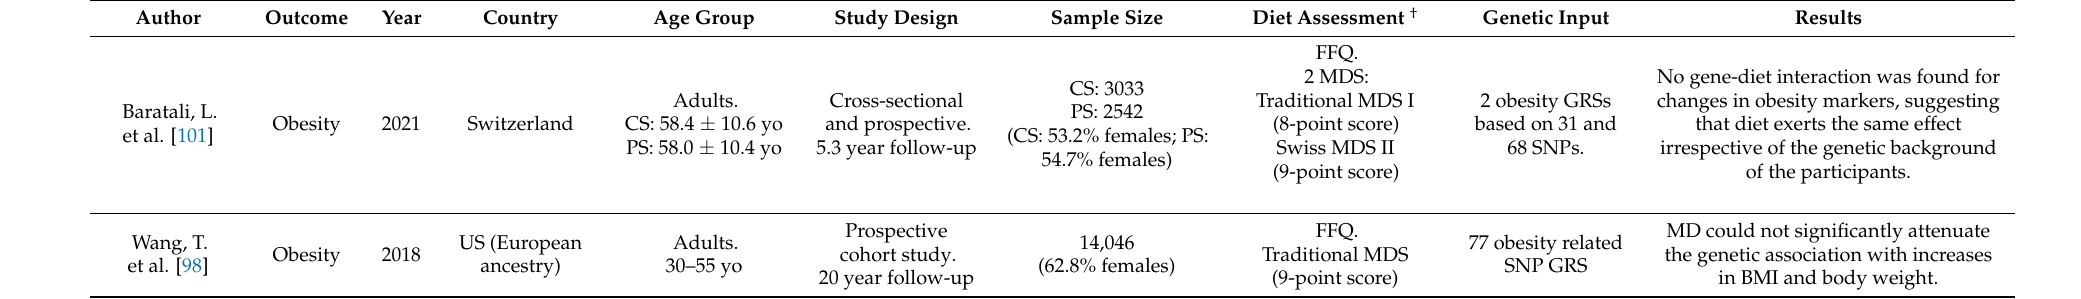
Table 2. Studies considering the MD as interaction factor to modulate the association between the genetic risk and obesity or MetS related outcomes in European adults. Articles ordered by outcome (starting by obesity, then MetS) and publication year (starting by the most